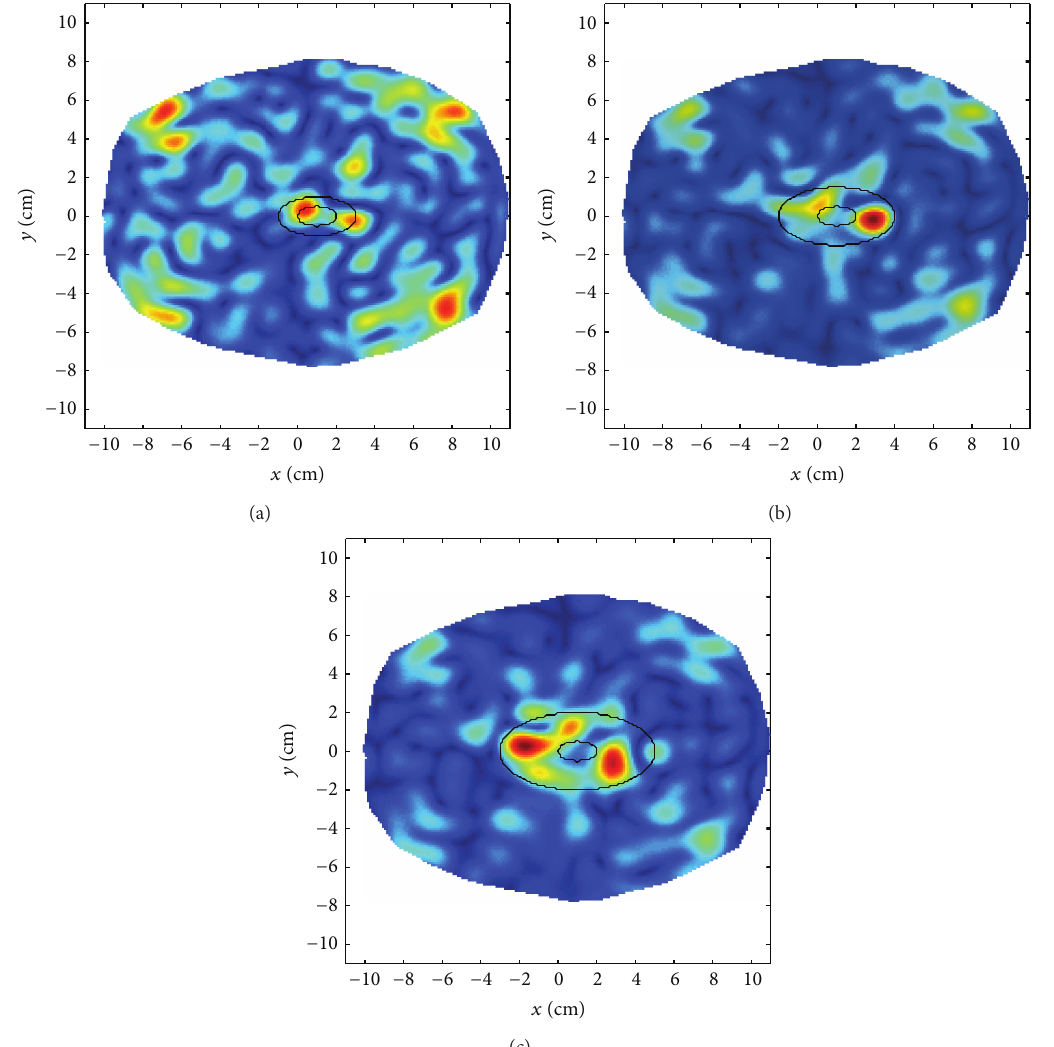
Figure 5: Followup of a postdiagnosis evolution of an ischemic brain stroke via the proposed differential TSVD imaging approach in realistic conditions. (a) 𝑡 1 ; (b) 𝑡 2 ; (c) 𝑡 3 . The images report the normalized amplitude of the differential contrast as retrieved from (4), so that red areas mark the portion of the head where changes are occurring. A gaussian noise with SNR = 70 dB and a 2 ∘ displacement of the probes have been assumed. The nonspecific reference head model is adopted in the TSVD